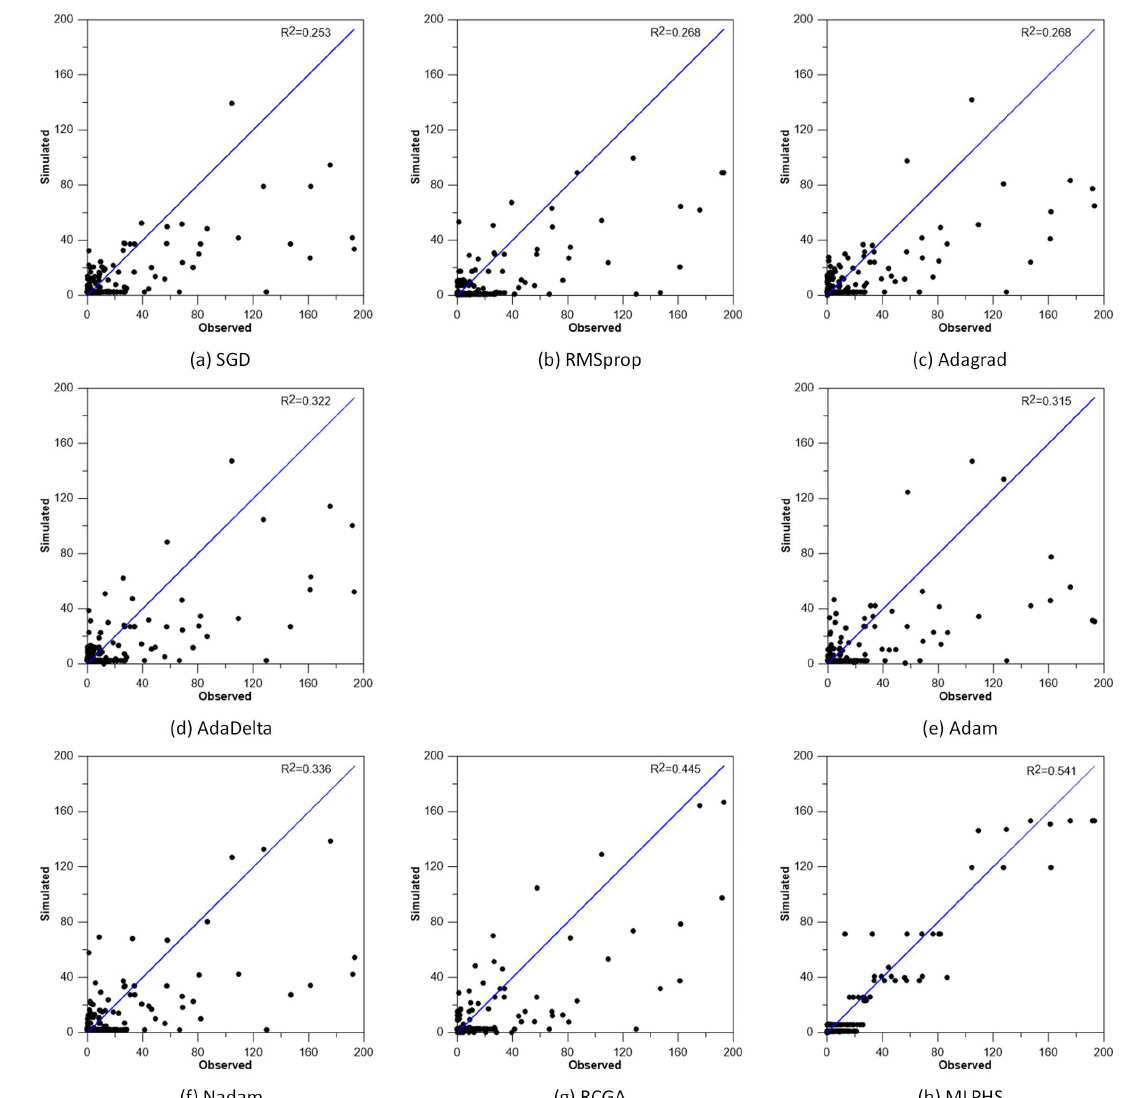
Figure 7. R 2 for observed and predicted data of MLP using the existing optimizers, MLP using the RCGA, and MLPHS.